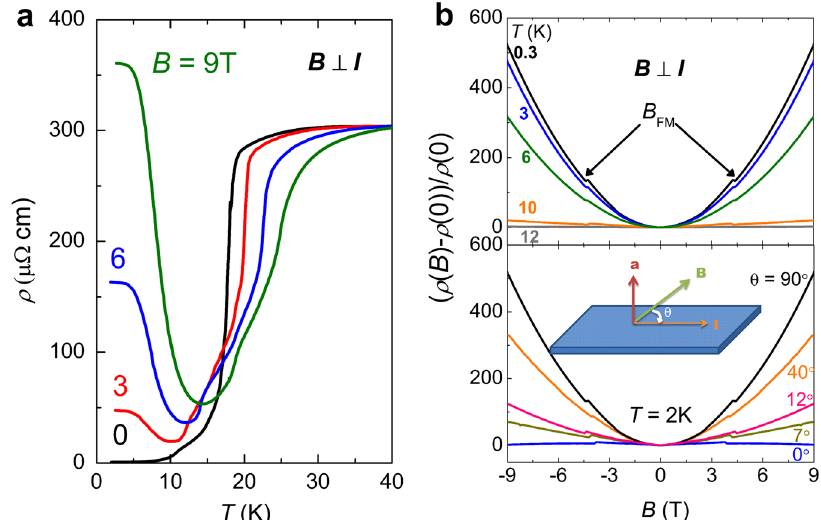
Fig. 2 Large positive magnetoresistance in CeSb for the magnetic fi eld applied perpendicular to the current. a Temperature dependence of the electrical resistivity of CeSb in various applied fi elds with B ⊥ I . At low temperatures, the fi eld leads to a signi fi cant enhancement of the resistivity indicating a large positive magnetoresistance. b Upper panel : Magnetoresistance as a function of applied fi eld with B ⊥ I at various temperatures, demonstrating that the positive magnetoresistance becomes much more signi fi cant below 10 K. The arrows point to B FM , the fi eld at which there is a transition from an AFF to the FM state with increasing fi eld. b Lower panel : Magnetoresistance as a function of applied fi eld for different θ , where θ is the angle between the applied fi eld and the current. As θ is reduced from 90°, the magnetoresistance decreases and becomes negative at high fi eld near 0°